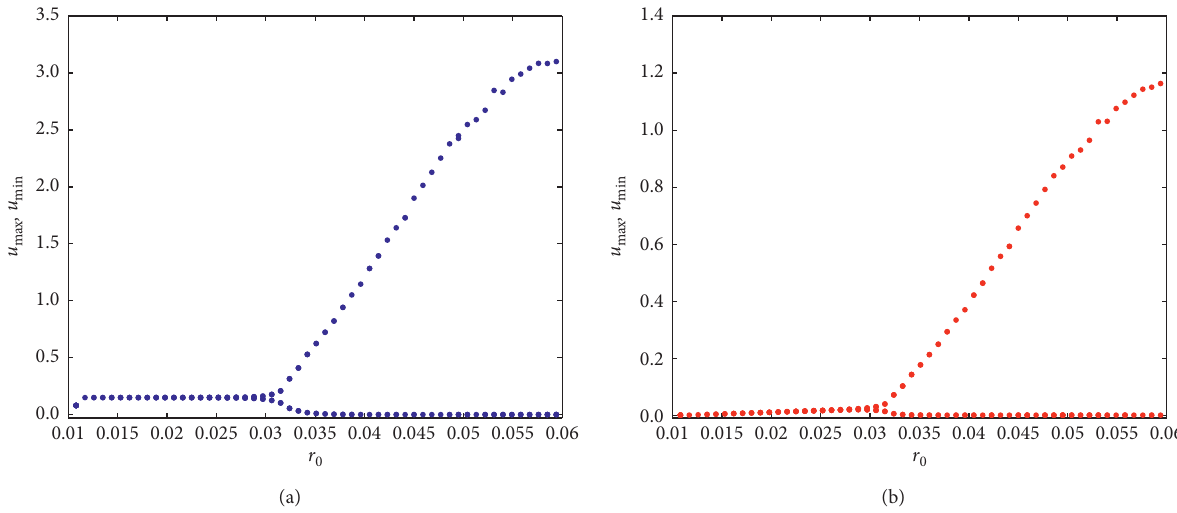
Figure 5: Bifurcation diagram with respect to the prey birth rate r Other parameter values are δ